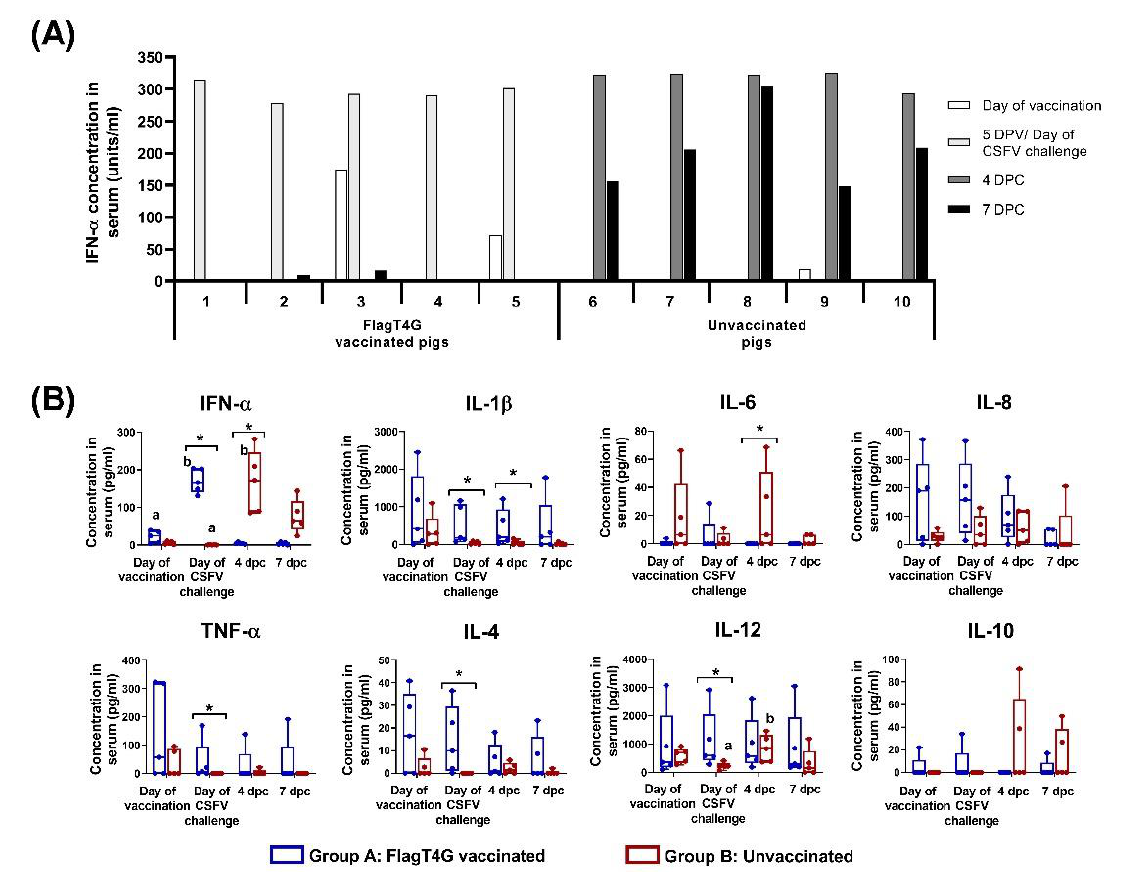
Figure 3. Cytokine response after CSFV vaccination and challenge. ( A ) IFN- α concentration in sera samples was evaluated after vaccination and CSFV challenge, using an in-house ELISA test. Individual results for each sampling are represented as the mean value (in units/mL) of duplicates performed for each sample. ( B ) Sera samples from vaccinated (blue boxes) and unvaccinated (red boxes) animals were also evaluated by Luminex assay for the detection of nine different cytokines. Mean values for each group at every sampling time are represented and cytokine concentrations are shown as pg/mL. Asterisk indicates statistically significant differences between groups on that particular sampling (Kruskal–Wallis non-parametric test; p < 0.05). Differences between a given sampling and the previous one within the same group (Friedman test) are represented by the letters on top of the bar: different letters show statistical difference ( p < 0.05). Not represented: IFN- γ concentration in sera (not detected in any sample).